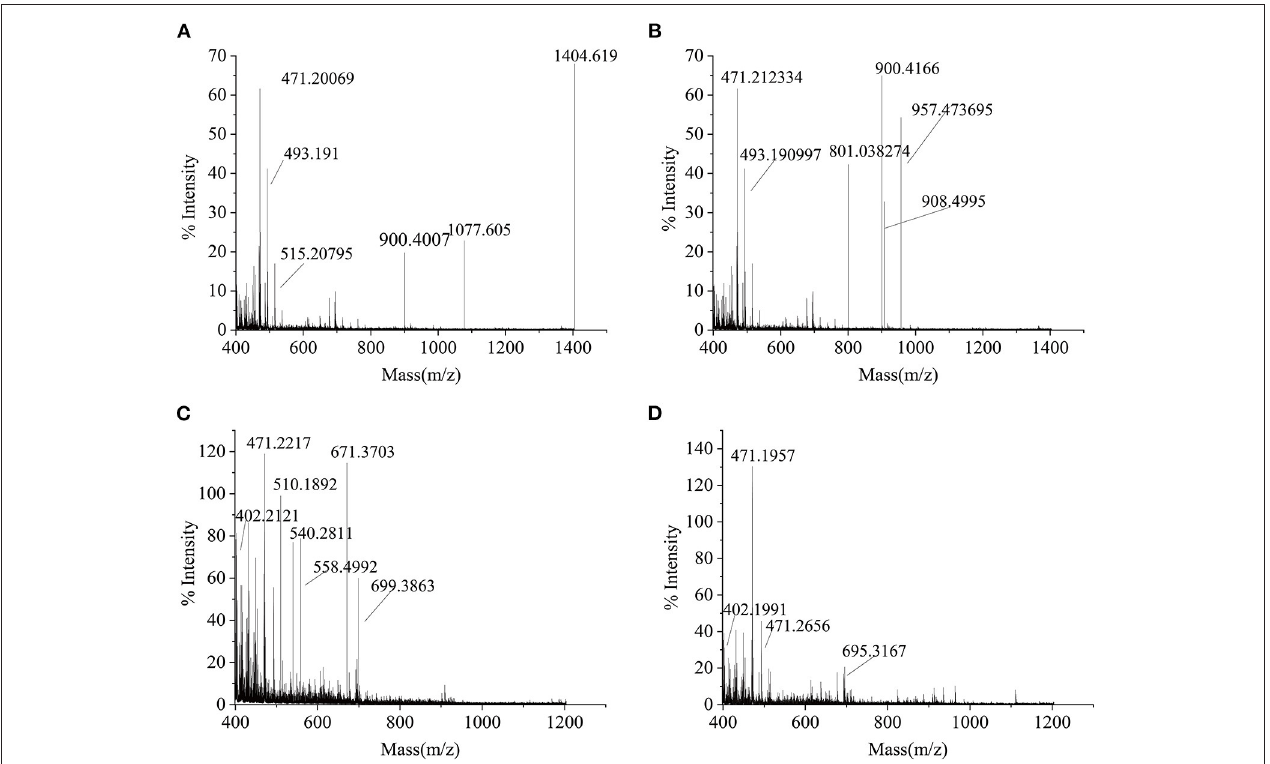
FIGURE 4 | Antioxidant capability of SCSPs. (A) DPPH • radical scavenging capability, (B) hydroxyl radical scavenging capability, (C) ferric-reducing/antioxidant power, (D) superoxide anion radical scavenging capability were measured under the action of SCSPs at 1, 2, 4, 6, 8, 10 mg/mL, respectively. Different capital letters denote significant differences between the SCSP, SCSP-I, SCSP-II, and SCSP-III groups at the same concentration ( P < 0.05), and different lowercase letters denote significant differences between the same fractions with different concentrations ( P < 0.05). All experiments were repeated three times. Data are expressed as mean ± standard